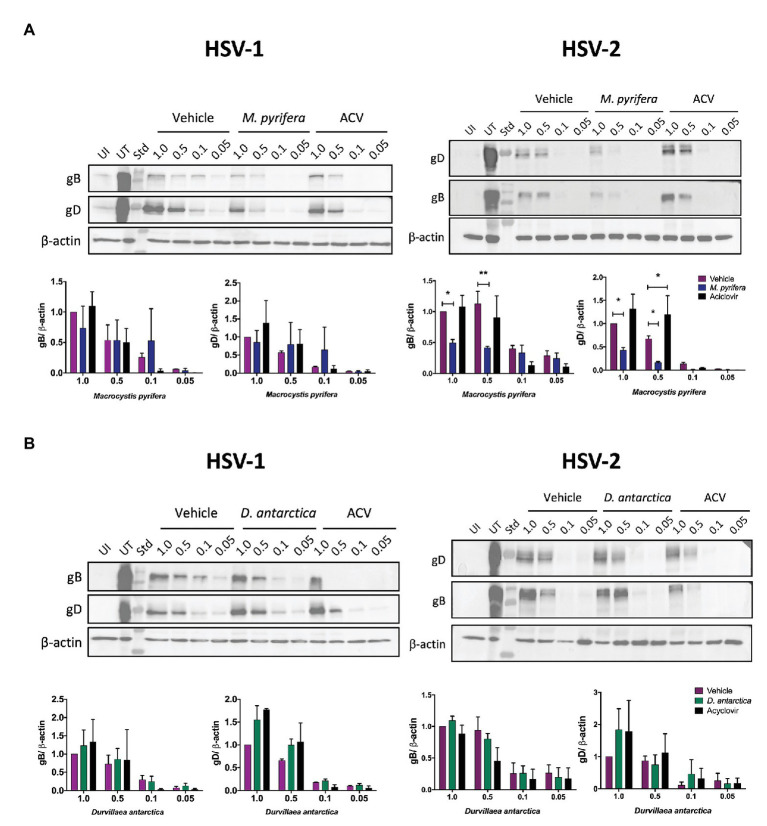
HSV binding to the surface of HeLa cells in the presence of the algae extracts. HeLa cells were treated with the M. pyrifera or D. antarctica extracts for 1 h. Then, the cells were incubated at 4°C for 15 min and later infected with different MOIs (1, 0.5, 0.1, or 0.05) of HSV-1 (left panels) or HSV-2 (right panels) for 5 h at 4°C, washed with saline buffer and immediately processed for protein extraction. (A) Western blot analyses of the viral proteins gB and gD in HeLa cells treated with the M. pyrifera extract or (B) the D. antarctica extract. Representative images are shown for the western blots. The quantifications were normalized relative to the vehicle and virus at an MOI 1 and corresponded to means ± SEM of two independent experiments for HSV-1 and three independent experiments for HSV-2. The intensity of the bands were quantified using ImageJ software The data were analyzed using two-way ANOVA and Dunnett’s multiple comparisons tests. **p < 0.01; *p < 0.05. UI, uninfected; UT, untreated; ACV, acyclovir; Std, standard.